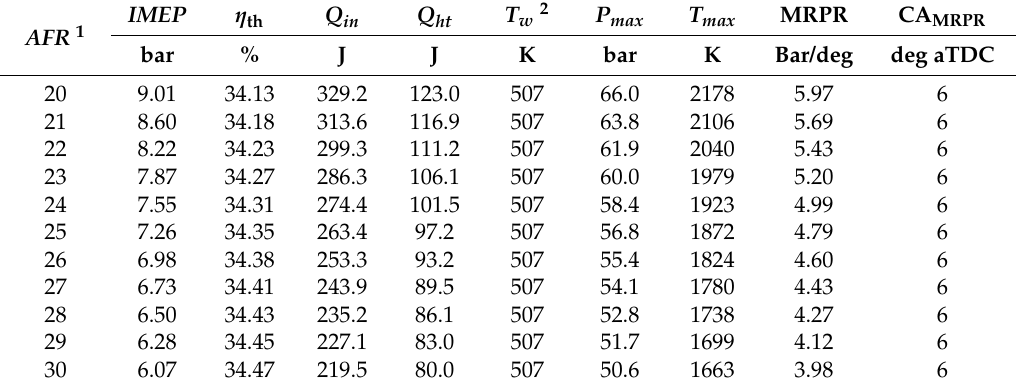
Table A5. Air cycle simulated results with various heat inputs for combustion pattern 2. AFR 1